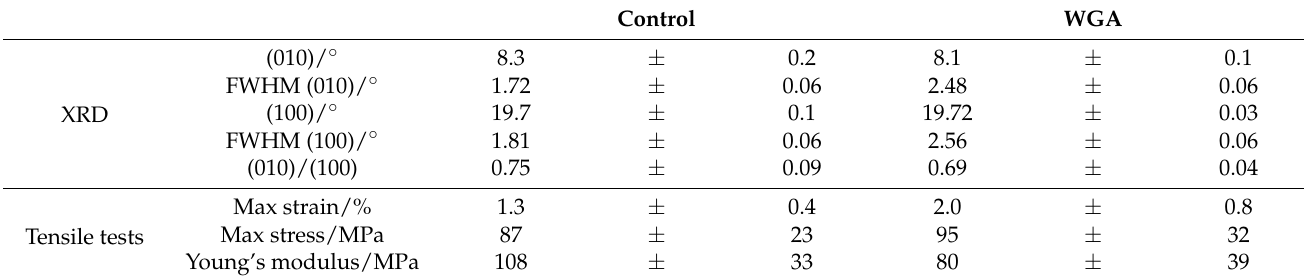
Table 1. Crystallographic and mechanical data of the blank control and the WGA-treated samples. Diffraction peaks were indexed according to Gardner and Blackwell (1975) [77]; (010)/100) refers to a ratio between the intensities of the two peaks. Tensile tests were carried out using WGA not functionalized with